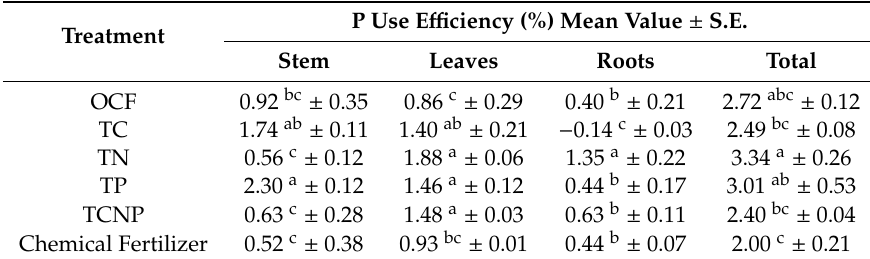
Table 6. E ff ect of treatments on phosphorus use e ffi ciency in maize plant parts. Treatment